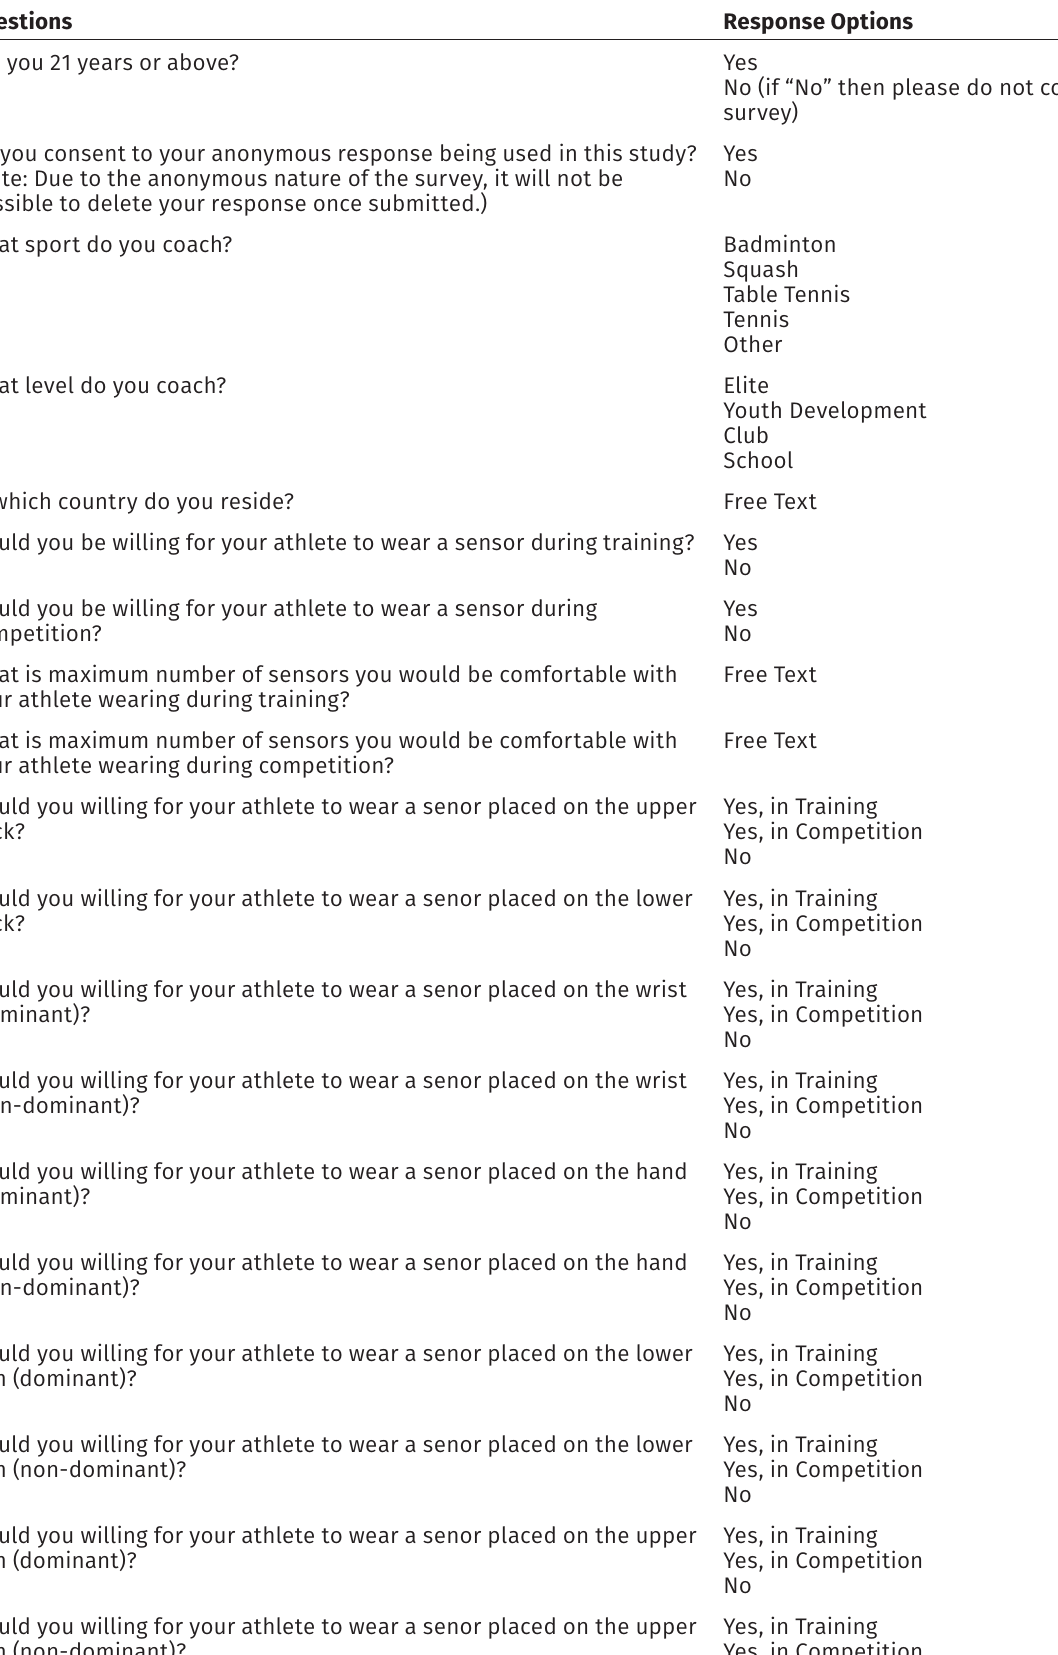
Table 2. Survey of Racket Sport Coaches on the use of Wearable Sensors during Training and